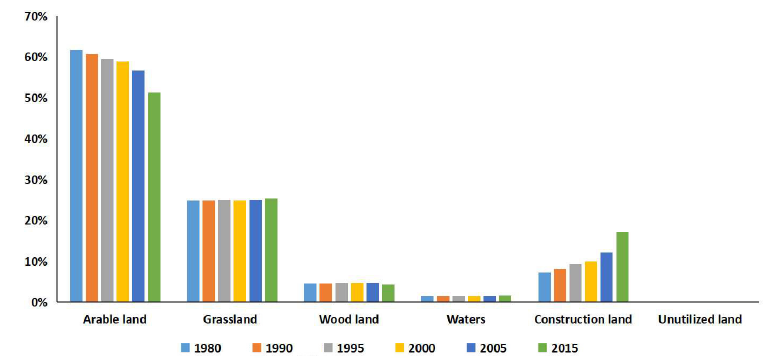
Figure 5. Percentages of land-use types in Chengdu from 1980 to 2015.